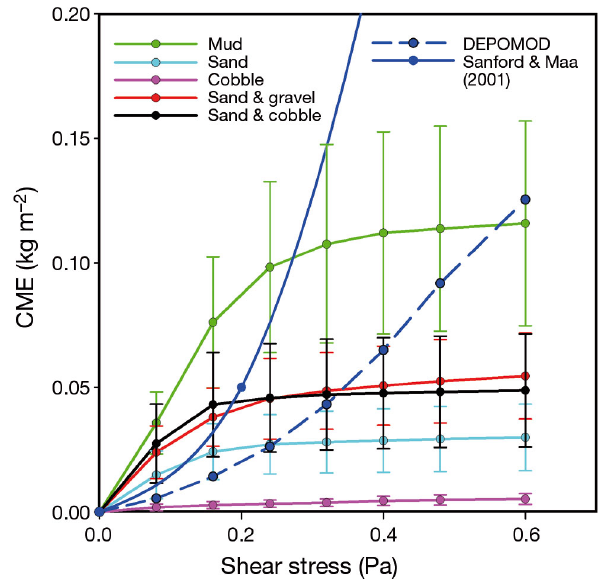
Fig. 4. Cumulative mass eroded (CME; mean ± SD) versus shear stress for the erosion experiments (n = 6 per substrate type) of salmon fecal waste material on 5 different bottom substrates (mud, sand, cobble, sand and gravel, sand and cobble). In addition, a DEPOMOD prediction is included based on elapsed time and an erodibility parameter of 7.0 × 10 −7 kg m −2 s −1 (Cromey et al. 2002a,b). The dark blue line describes the actual data of Maa et al. (1998) which is de- scribed in detail in Sanford & Maa (2001) and is included